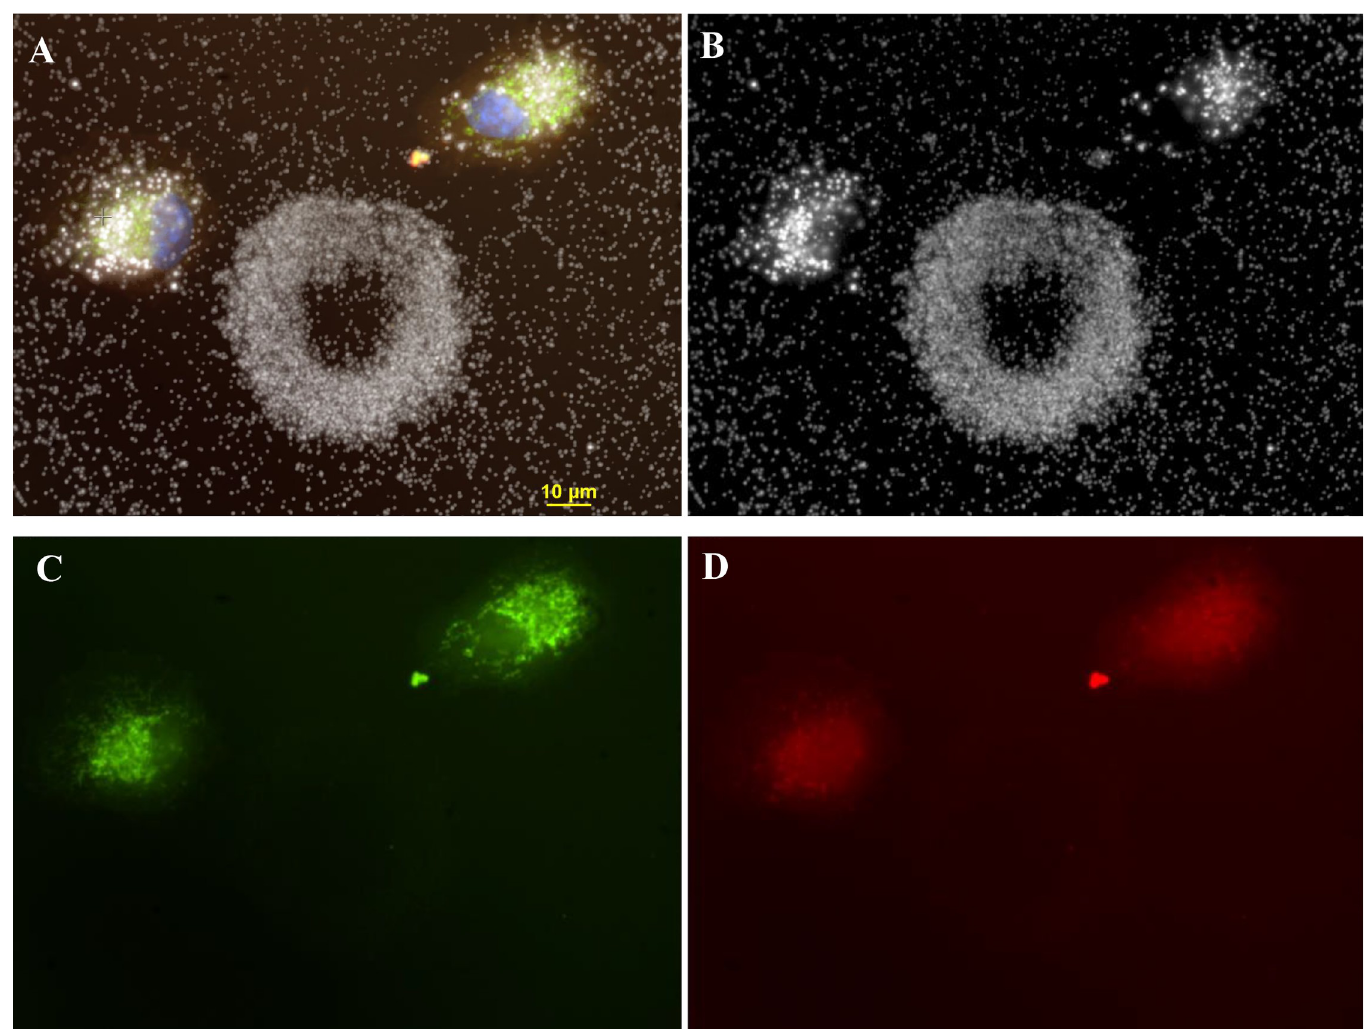
Fig 10. The four-panel figure of cell shown in Fig 2C was treated with 3ug/ml AgNP. Panel A. The individual dark field (B) and fluorescent images (C, D) were combined into a composite image (A). DAPI stained nuclei (blue) image was added to the composite image. Panel B. Darkfield image of a ring structure with 2 newly divided cells adjacent to the top of ring structure. Panel C. Cells transfected with Mito-GFP (green). Panel D. Cell stained with CellMask Orange plasma membrane stain. Magnification